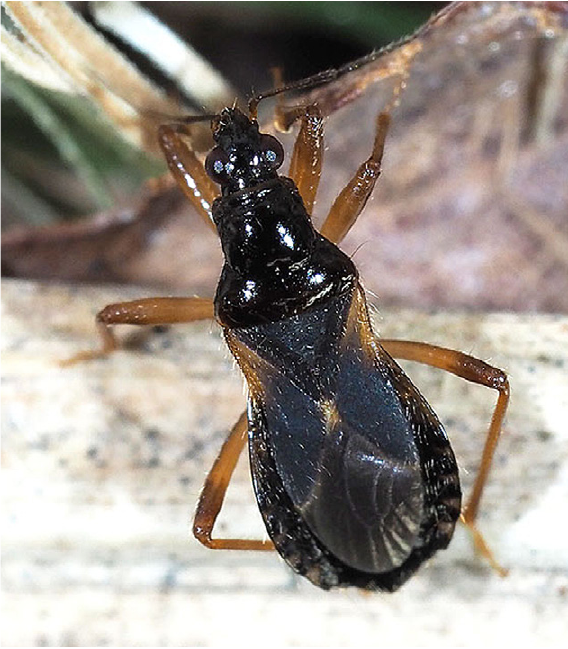
Figure 3. Photograph of a living adult of Alloeorhynchus reinhardi from Oita, Kyushu, Japan.